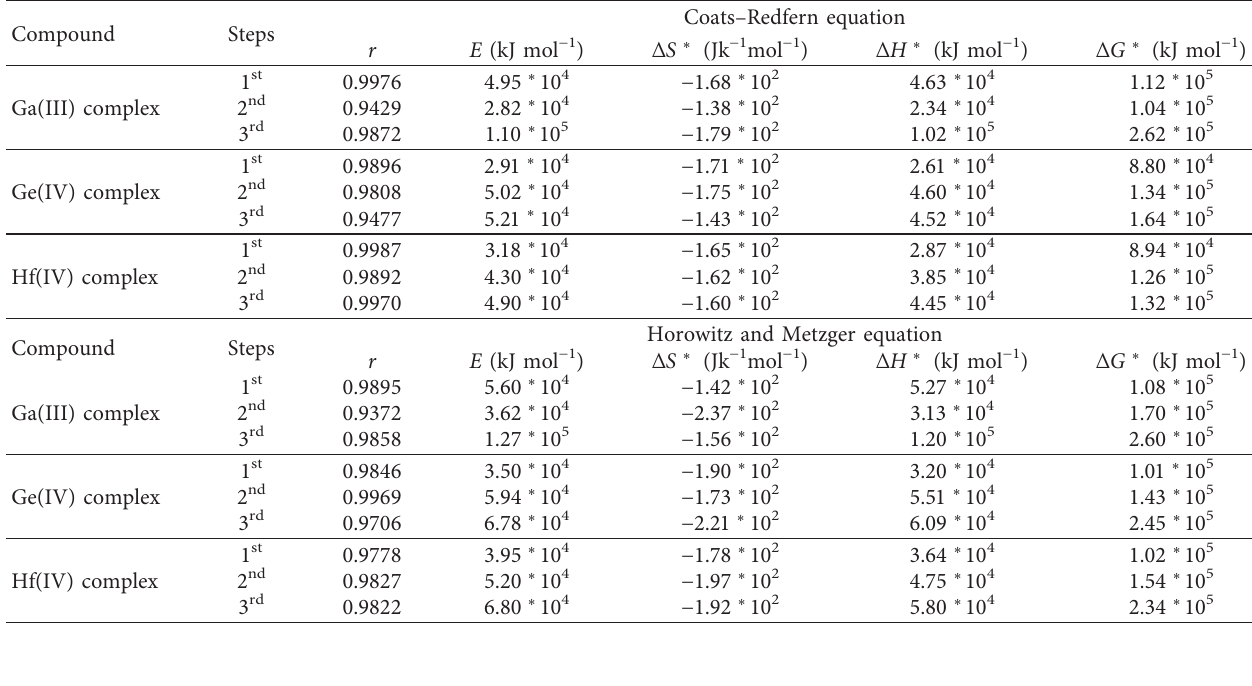
2 and synthesized complexes.